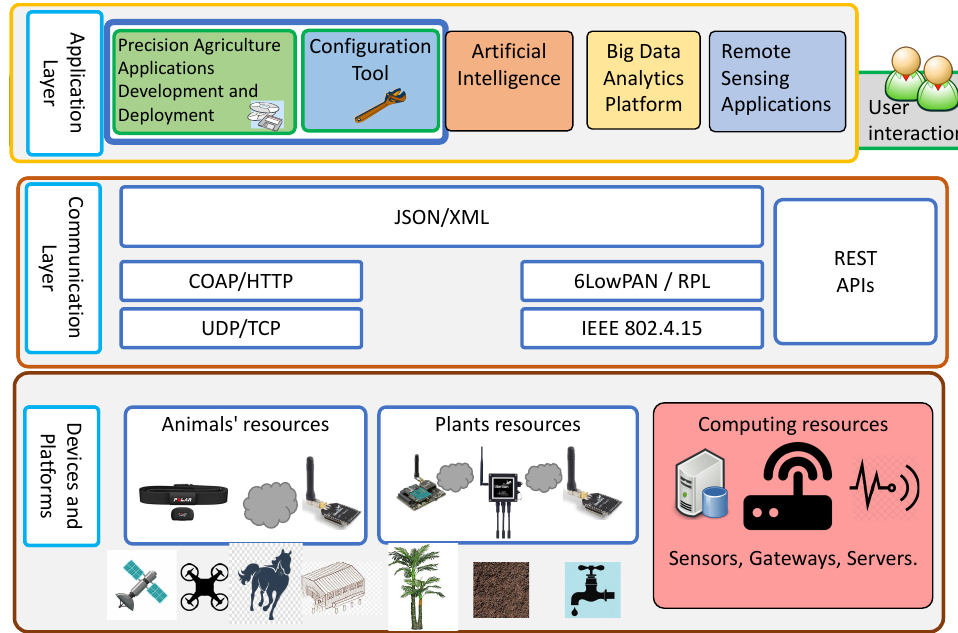
Figure 1. Proposed IoT system model for precision agriculture, showing the relationship between various entities such as sensors, network-enabling technologies, and agricultural resources for real- time monitoring and